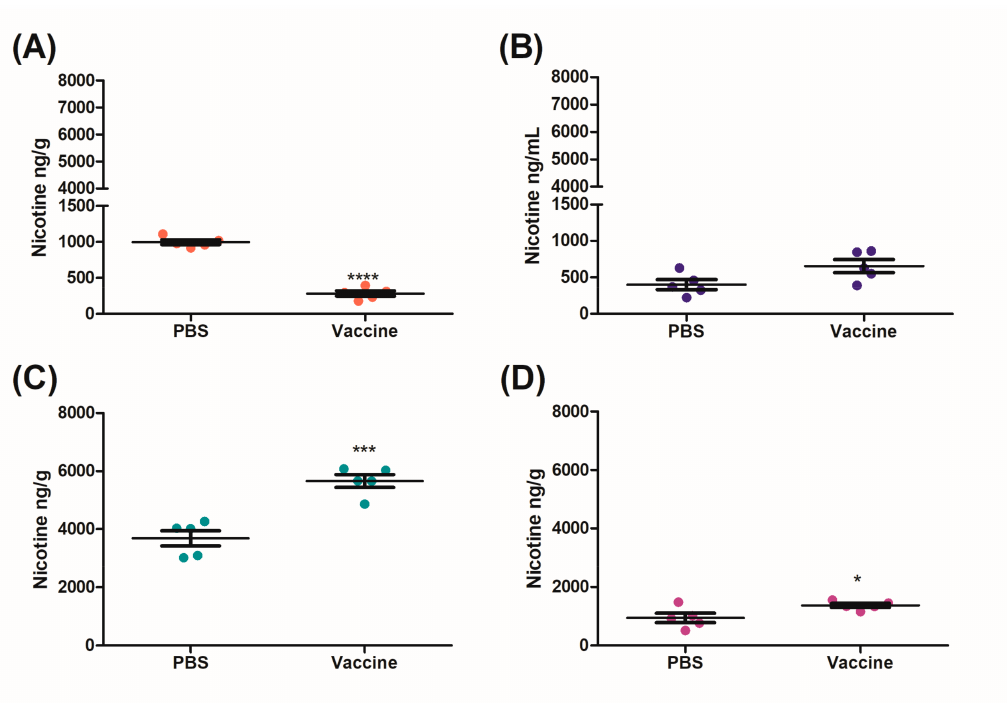
Figure 5. Distribution of nicotine in mice vaccinated IM/IN after a mucosal nicotine challenge. IM/IN vaccinated mice were challenged with 0.09 mg/kg of nicotine by an IN instillation of 10 µ L per nare. After 10 min the mice were euthanized by a cardiac exsanguination and organs were collected for nicotine distribution analysis. ( A ) Brain, ( B ) sera, ( C ) lung, ( D ) heart and data are represented as ± SEM and n = 5 for each group. Statistical significances were determined by an unpaired two-tailed T-test, * p = 0.0384, *** p = 0.0004, and **** p <